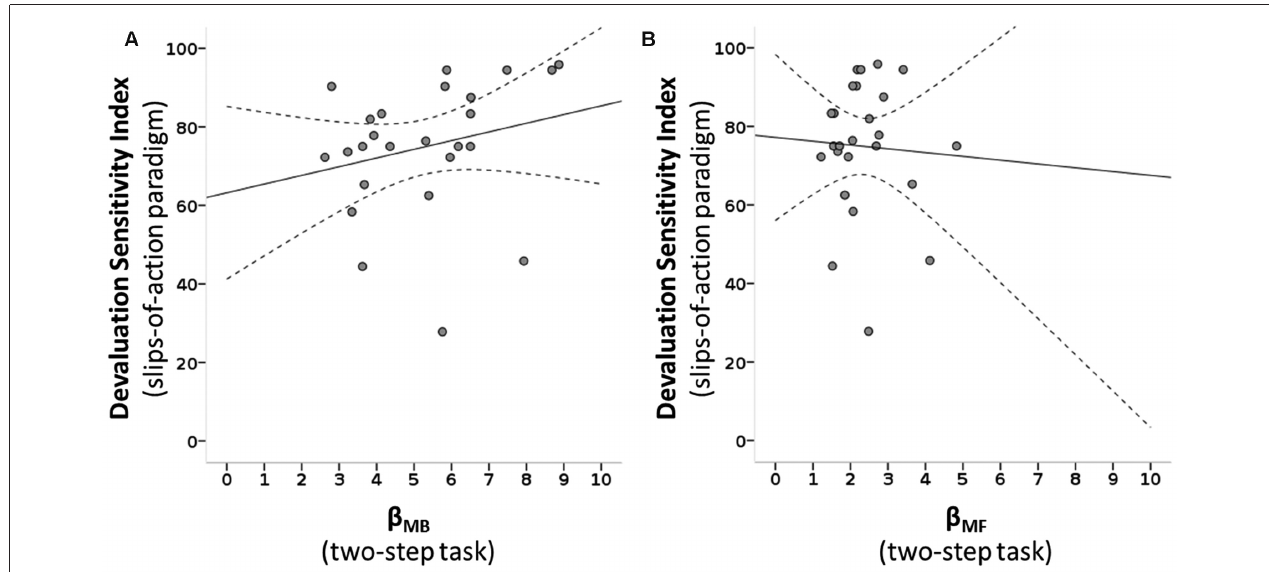
FIGURE 5 | Scatterplots of MB and MF choice values of the two-step task and devaluation sensitivity of the slips-of-action paradigm. (A) A positive correlation is seen between the MB parameter of the two-step task ( β MB ) and the devaluation sensitivity index (DSI) of the slips-of-action task: ρ ( 25 ) = 0.431, R 2 = 0.055, p = 0.016. (B) No significant association is seen between the MF parameter of the two-step task ( β MF ) and the DSI: ρ ( 25 ) = 0.172, R 2 = 0.003, p = 0.205. Dotted lines: 95% confidence interval.